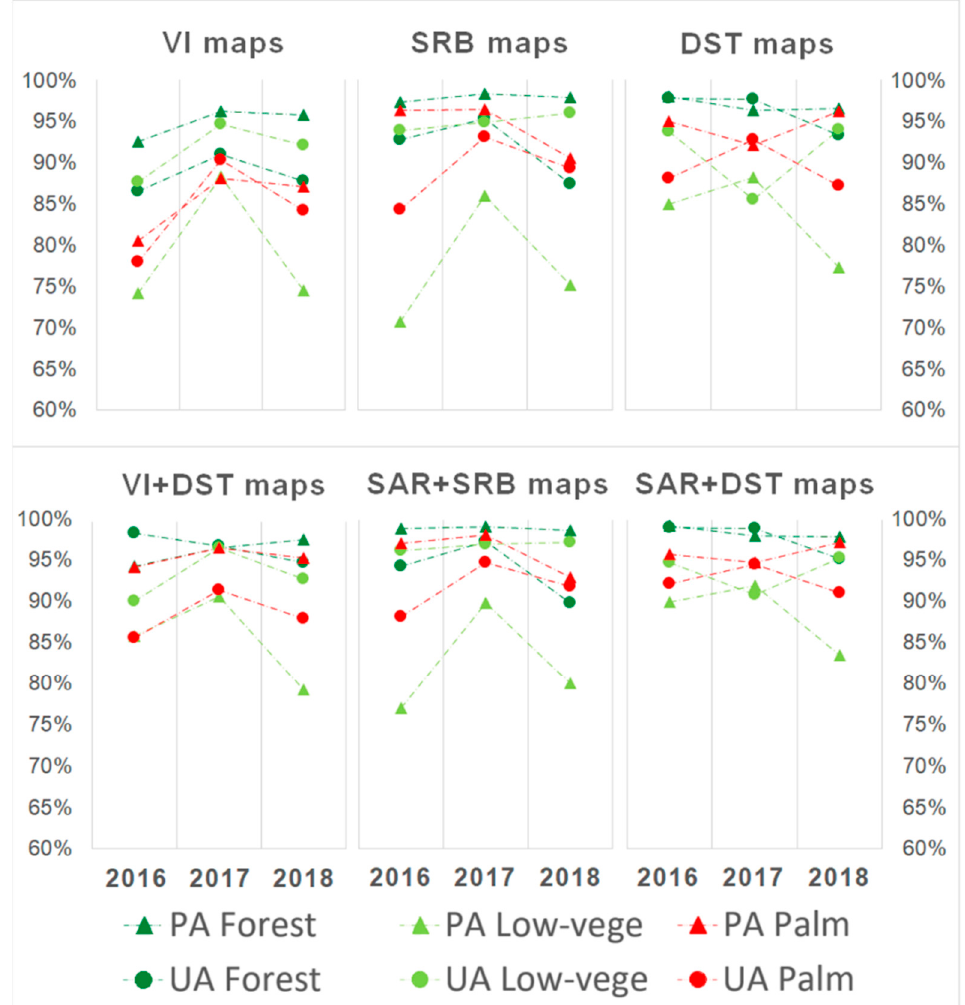
Figure 5. Comparison of Producer’s Accuracy (PA) and User’s Accuracy (UA) of the three land-cover types over the three-year analysis of the selected thematic maps (i.e., the maps with the highest OA and Kappa, three maps created by using single-data-sources approach and three with data-fusion approach).